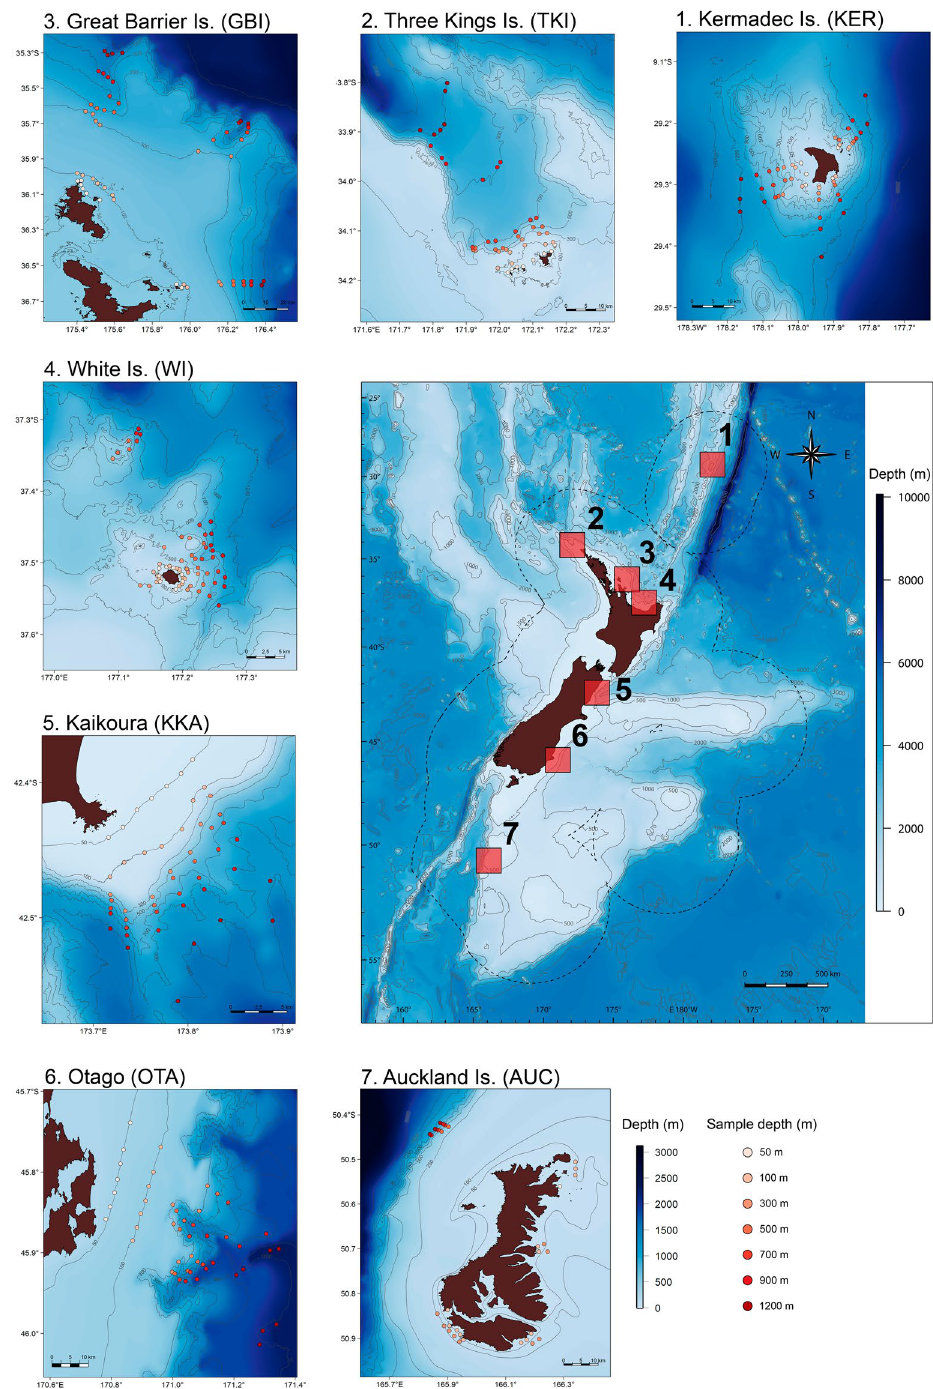
Figure 1. Latitudinal beta diversity sampling sites. Fishes were sampled at multiple depths (50, 100, 300, 500, 700, 900 and 1200 m) using baited remote underwater stereo-video (stereo-BRUVs) deployments at each of seven locations: Kermadec Islands, Three Kings Islands, Great Barrier Island, White Island, Kaikoura, Otago and the Auckland Islands. Map created using R 85 . Bathymetry source: Depth contour polyline